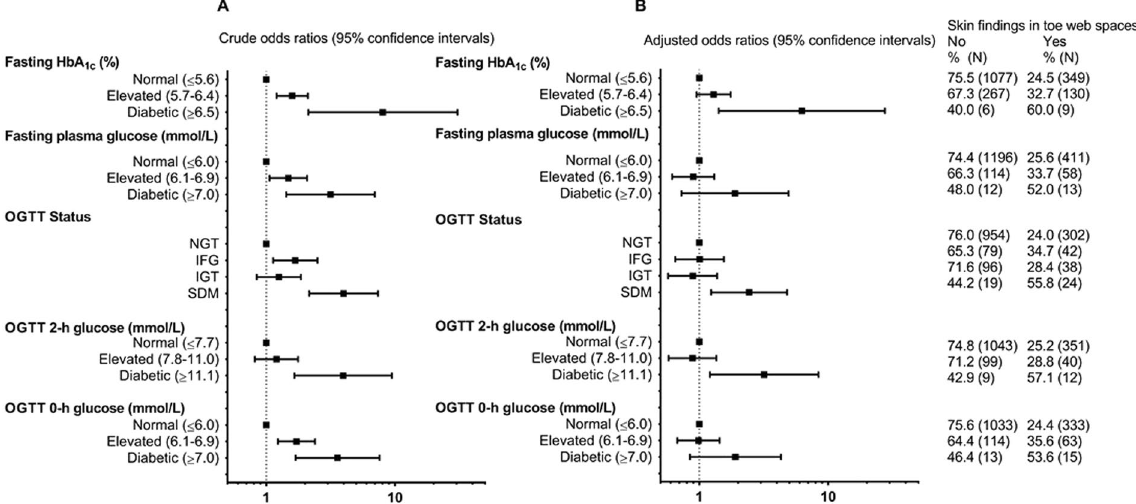
Figure 1. Forest plot of risk for abnormal glucose metabolism in subjects with skin changes in toe web spaces. Multinomial logistic regression analysis, crude ( A ) and adjusted ( B ) odds ratios and their 95% confidence intervals are presented. Adjustments are made for body mass index, smoking, physical activity, education and sex. OGTT = oral glucose tolerance test, NGT = normal glucose tolerance, IFG = impaired fasting glycaemia, IGT = impaired glucose tolerance, SDM = screen-detected diabetes. Skin changes in toe web spaces = maceration, scales, vesicles or localized erythema were systemically recorded as abnormal cutaneous findings of the toe web